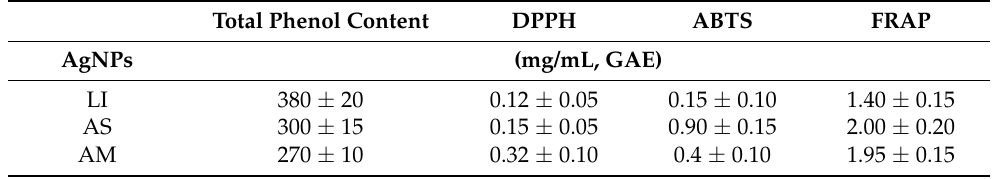
Table 2. Biochemical characterization of AgNPs prepared using extracts from L. indica (AgNPs_LI), A. scholaris (AgNPs_AS), and A. multifolium (AgNPs_AM). (a) Concentrations of total phenolic content on the surface of AgNPs. The ability of AgNPs to quench free oxygen radicals—(b) ABTS, (c) DPPH, and (d) FRAP methods. GAE—gallic acid equivalent. All measurements were performed in no less than five replicates.